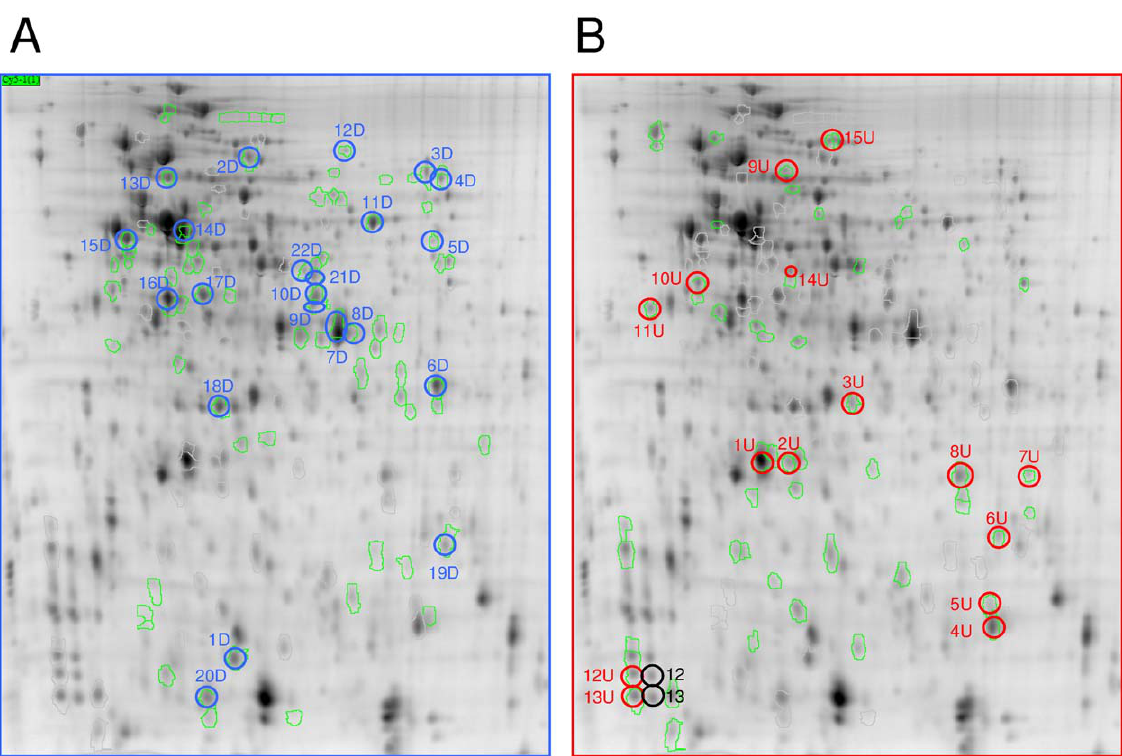
Figure 4. A representative standard 2D gel showing protein spots that were down-regulated (A) and up-regulated (B). Proteins of interest are circled in green, and excised spots are circled in blue or red according their relative spot volumes (D=down-regulated by UVB; U=up- regulated by UVB). Green circles correspond to the up- or down-regulated proteins not excised for MS analysis.